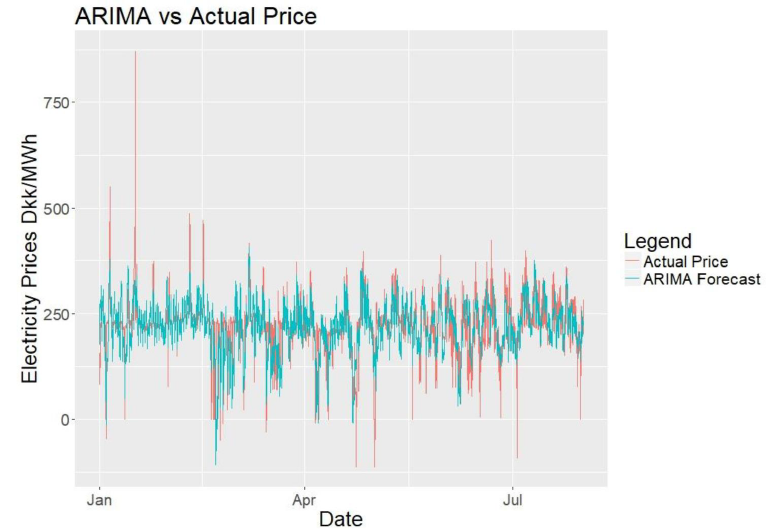
Figure 18. ARIMA vs. Actual price.